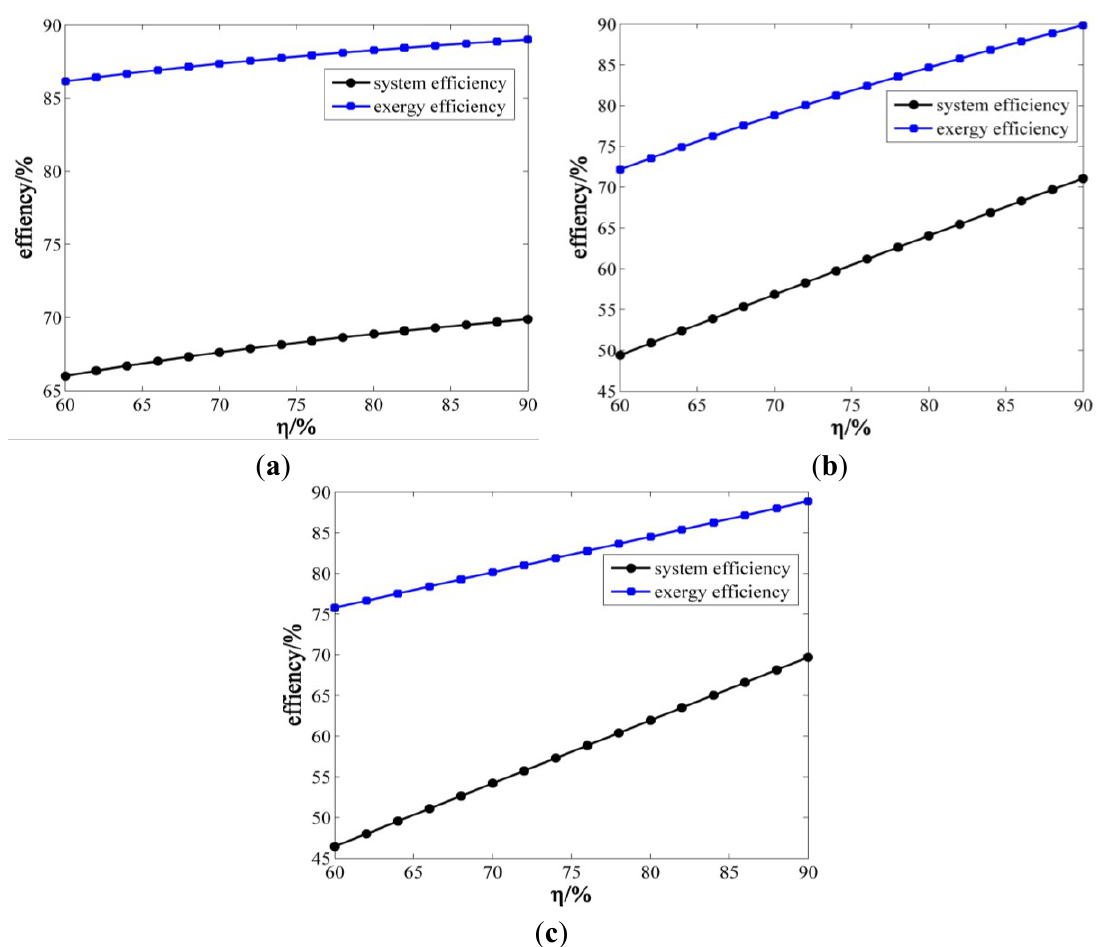
Figure 8. The variation of system efficiency with mechanical efficiency: ( a ) the variation of compressor efficiency; ( b ) the variation of water pump efficiency; and ( c ) The variation of hydroturbine